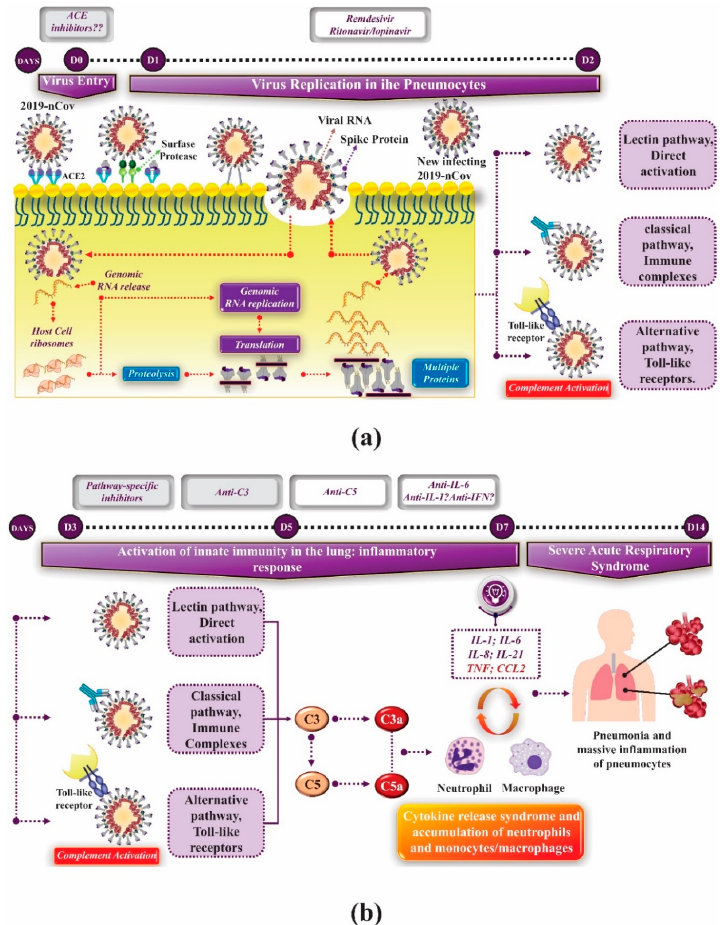
Figure 5. A possible scheme for using complement system inhibitors in lung injury associated with SARS-CoV-2: ( a ) SARS-CoV-2 penetrates the host’s pneumocytes and uses the cellular machinery for protein synthesis and replication of the genetic material and causing activation of the complement system through different pathways; ( b ) Complement activation contributes to the massive inflammatory response of pneumocytes observed in some patients with severe COVID-19. The inhibition of C3 or C5 can have significant therapeutic potential [59]. Note: This image was developed using the CorelDraw software (2017 Corel Corporation ID